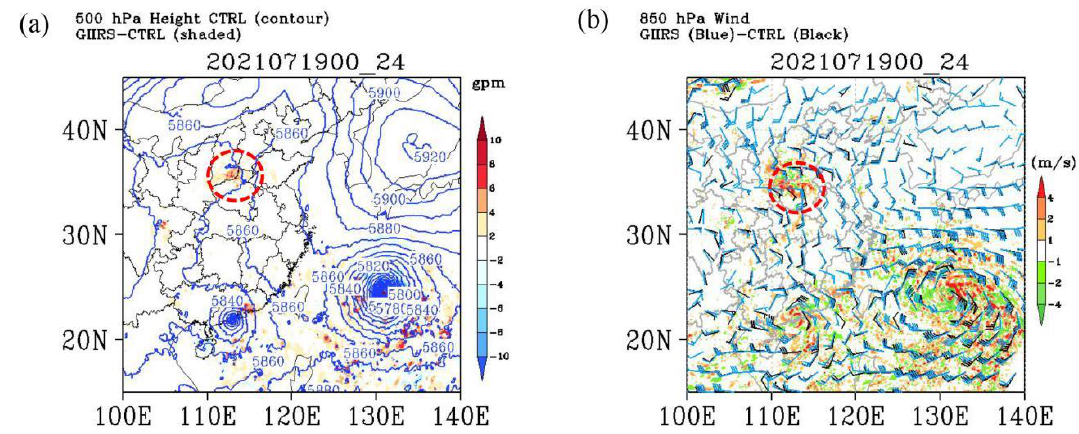
Figure 6. ( a ) Geopotential height (gpm) at 500 hPa in the CTRL experiment (blue contour) and the differences between the GIIRS and CTRL experiments (shaded), the ( b ) wind directions of the GIIRS (blue barbs) and CTRL (black barbs) experiments at 850 hPa, and the wind speed (m s −1 ) differences between the GIIRS and CTRL experiments (shaded) at 850 hPa at 0000 UTC on 20 July 2021.